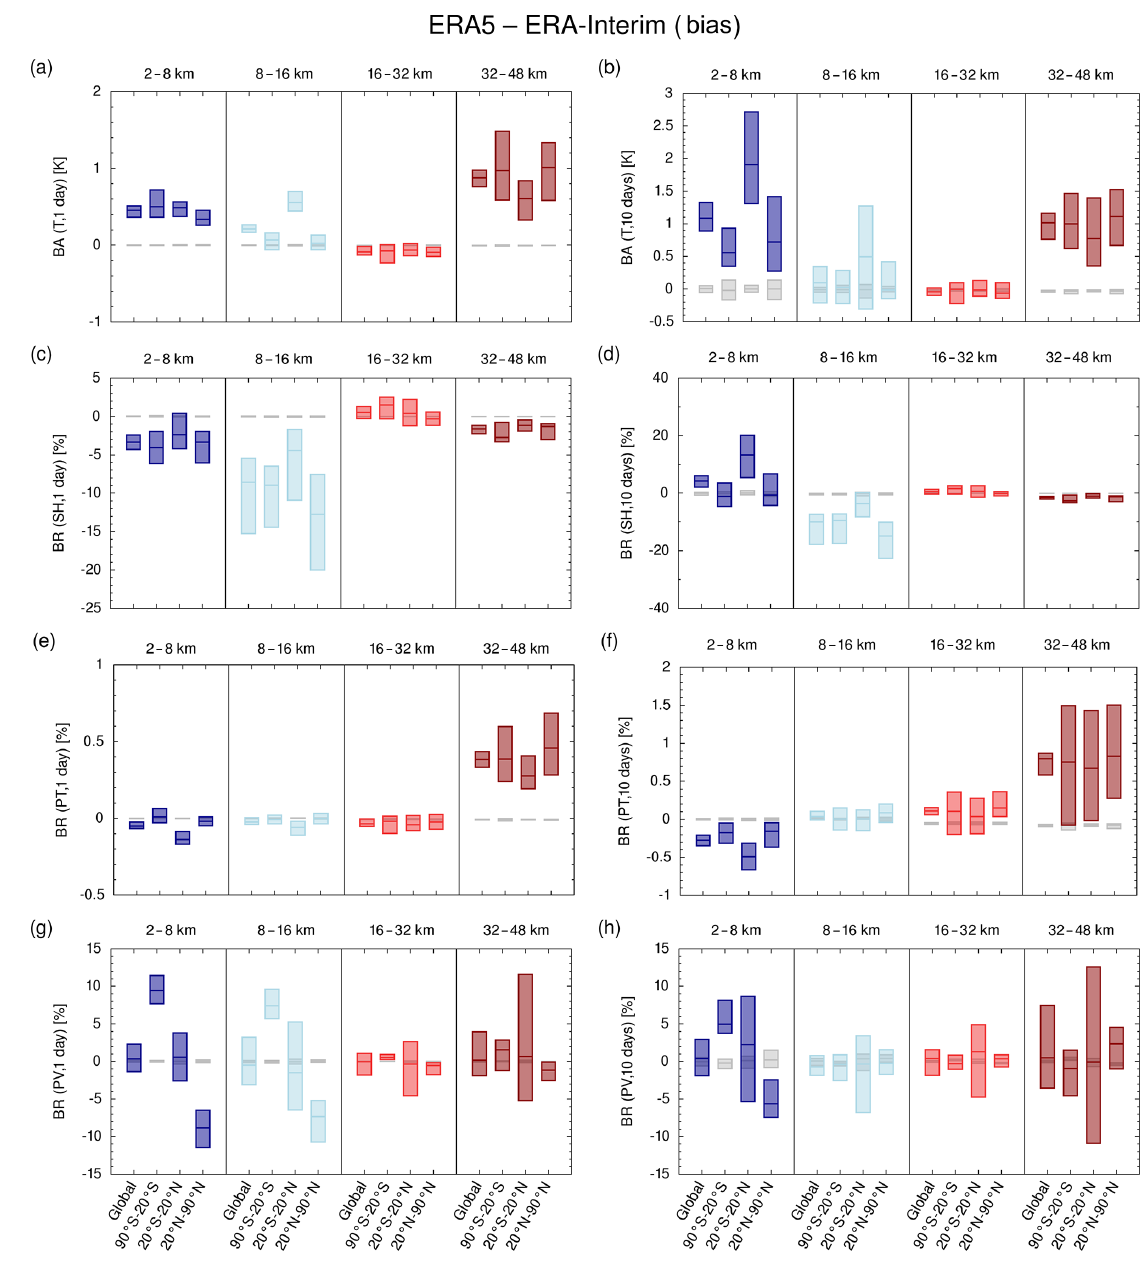
Figure 11. Temperature ( T ), specific humidity (SH), potential temperature (PT), and potential vorticity (PV) bias between ERA-Interim and ERA5 (blue and red bars) and due to parameterized diffusion and subgrid-scale wind fluctuations (light gray bars) after 1 day (a, c, e, g) and 10 days (b, d, f, h) of simulation time. Bars indicate the peak-to-peak range and the median of 24 trajectory simulations covering the year